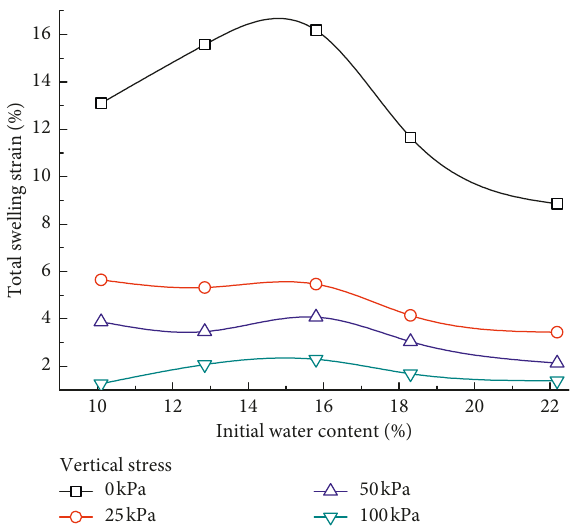
Figure 11: Relation between the swelling strain and moisture content with dry density of 0.16kN/m 3 .